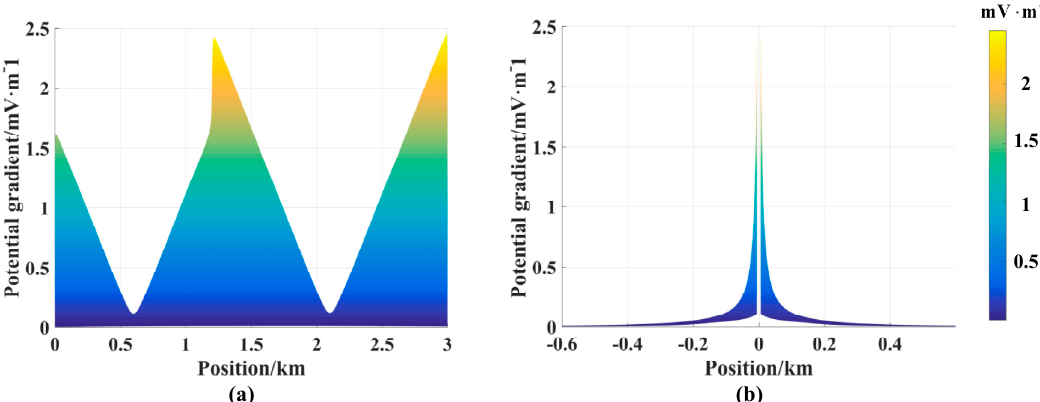
Figure 6. Surface potential gradient near the running rail under the bilateral power supply: ( a ) Along the locomotive running direction; ( b ) Vertical to the locomotive running direction.